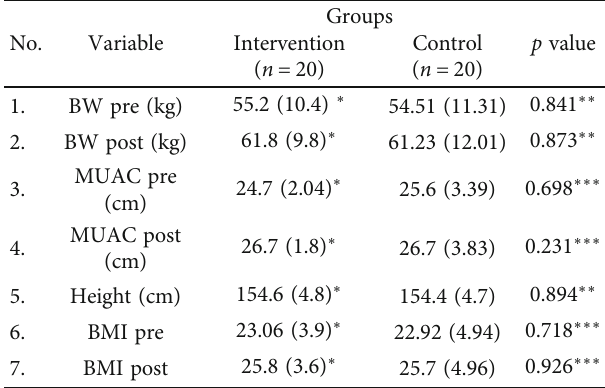
Table 2: Comparison of demographic characteristics of intervention and control groups.